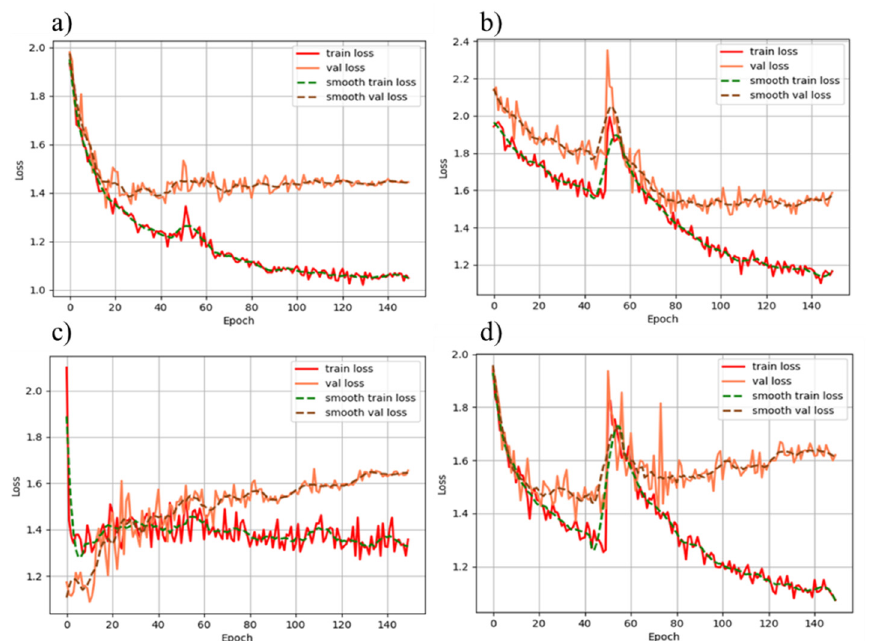
Figure 13. Comparison of different network training losses: ( a ) Loss when training with DToolnet; ( b ) Loss when training with a resnet50-based Faster RCNN; ( c ) Loss when training without a transfer learning network; ( d ) Loss when training with a vgg16 ‐ based Faster RCNN.